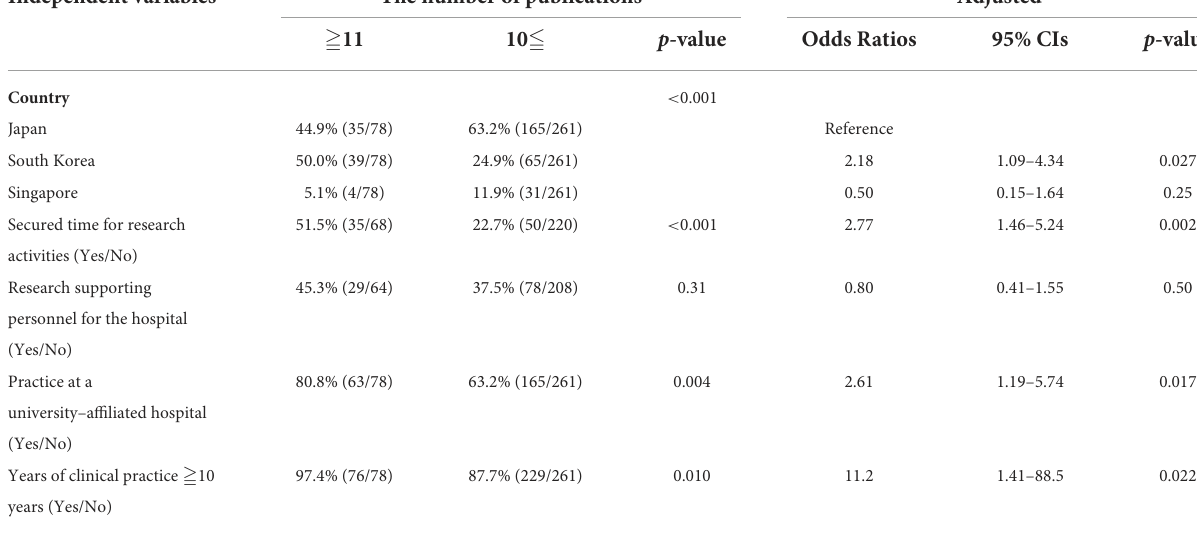
TABLE 4 Associated factors with the number of